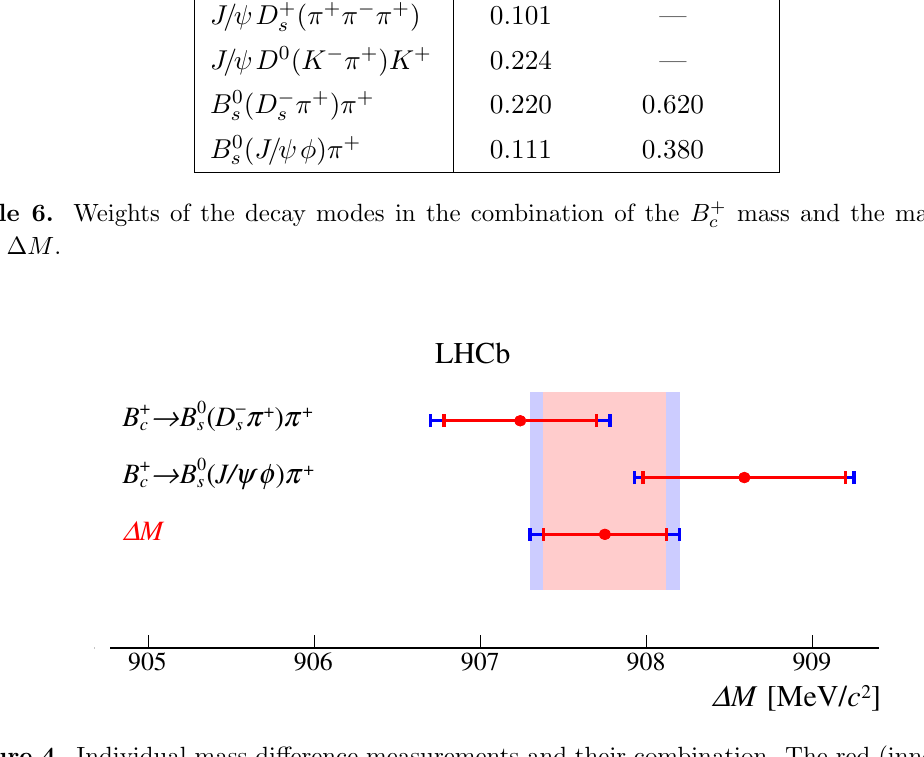
Figure 4. Individual mass di(cid:11)erence measurements and their combination. The red (inner) cross- bars show the statistical uncertainties, and the blue (outer) cross-bars show the total uncertainties on the measurement.